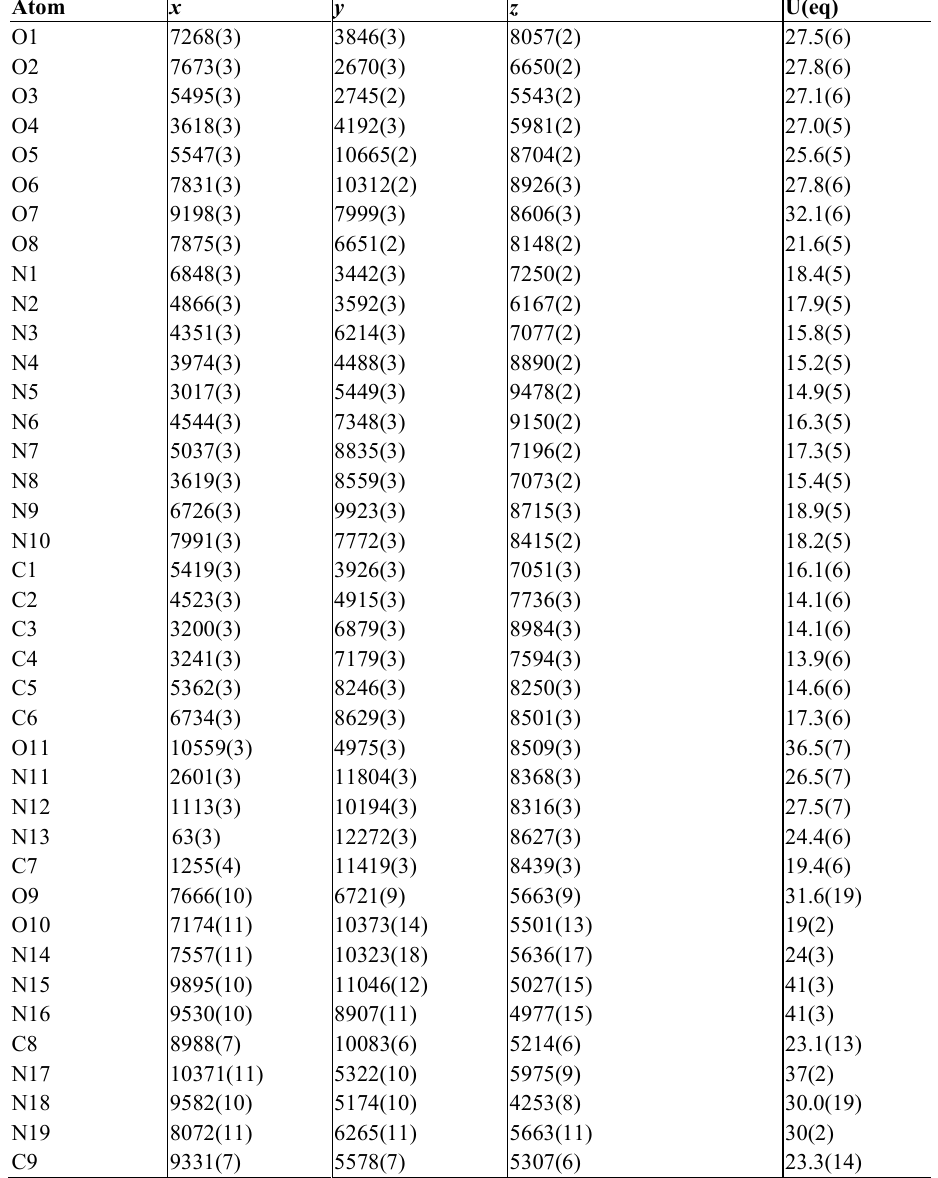
Table 2 . Fractional Atomic Coordinates (×10 4 ) and Equivalent Isotropic Displacement Parameters (Å 2 ×10 3 ) for 1 . U eq is defined as 1/3 of of the trace of the orthogonalised U IJ tensor.